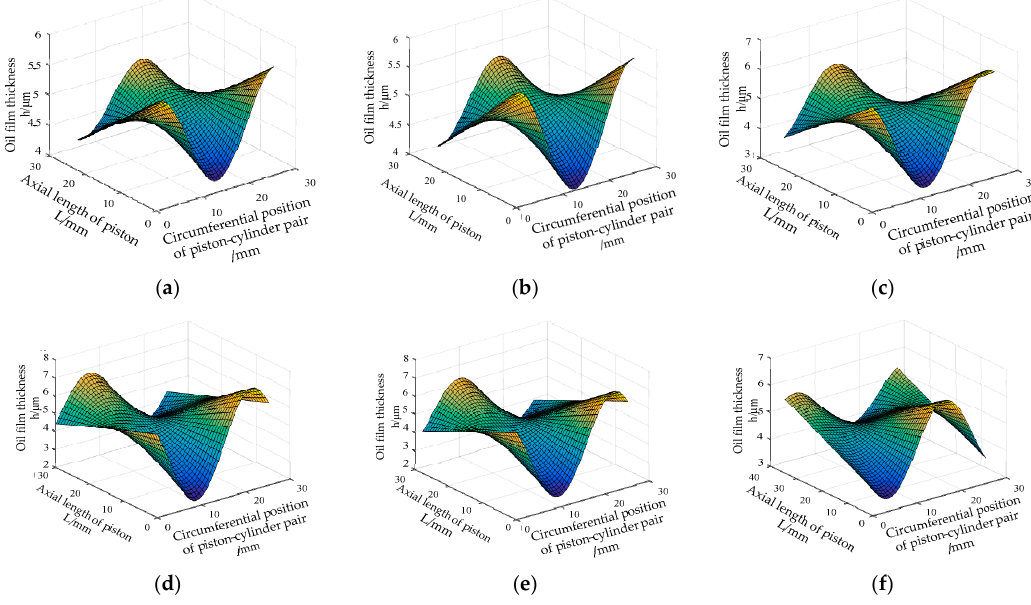
Figure 9. The figure shows the distribution of oil film thickness under different inclined plate rotation angles under ultra-high pressure conditions: ( a ) Oil film thickness distribution with inclined disk rotation of 1°; ( b ) oil film thickness distribution with inclined disk rotation of 10°; ( c ) oil film thickness distribution with inclined disk rotation of 45°; ( d ) oil film thickness distribution with inclined disk rotation of 90°; ( e ) oil film thickness distribution with inclined disk rotation of 110°; ( f ) oil film thickness distribution with inclined disk rotation of 210°.